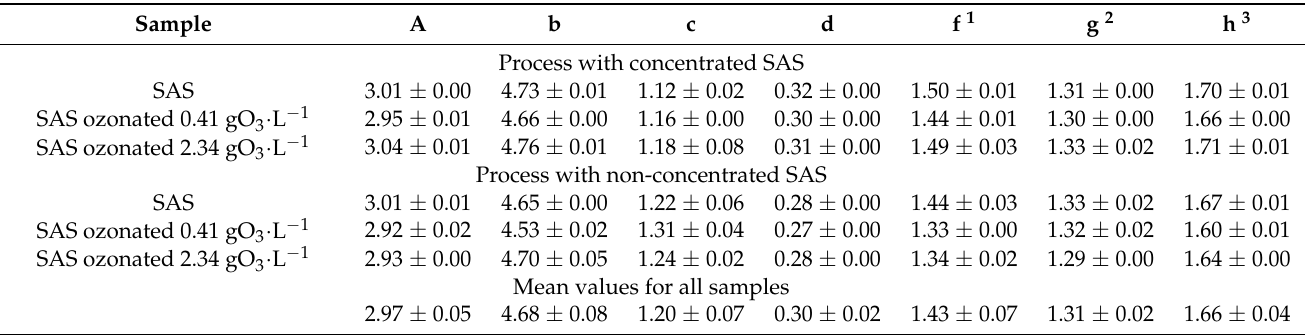
Table 2. Stoichiometric coefficients for Equations (1) and (3) calculated based on elemental and dry solids